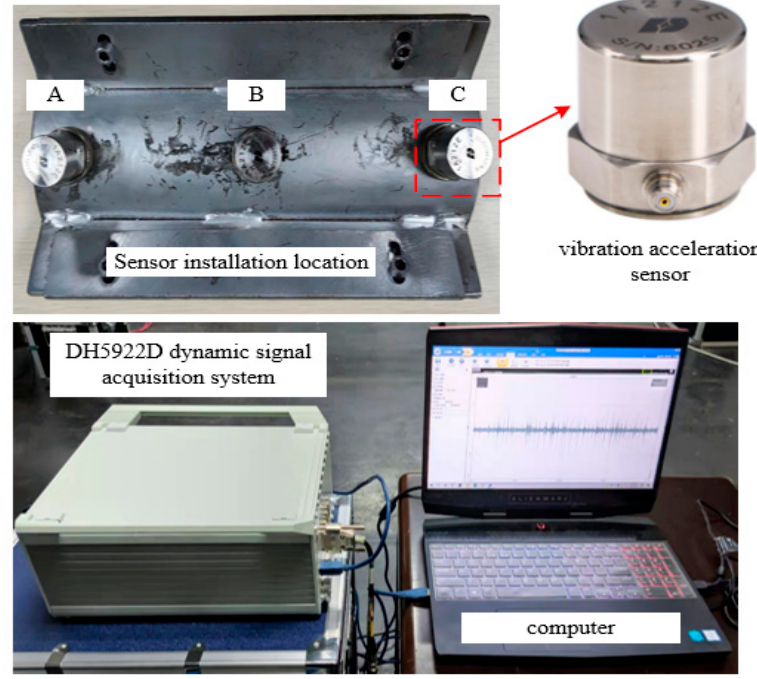
Figure 3. Movement images of spherical particles.